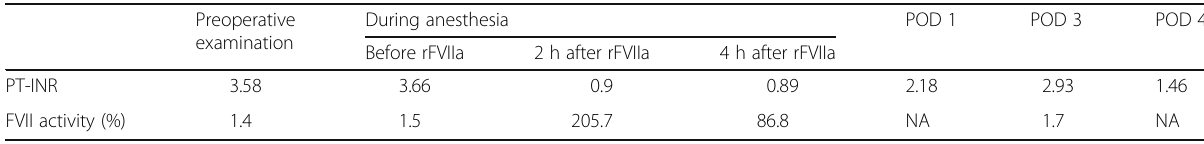
Table 1 PT-INR and FVII activity during perioperative period Preoperative During examination